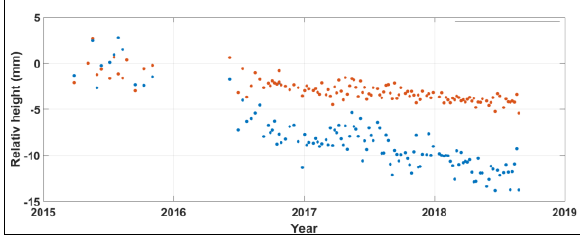
Figure 8: Time series from PSI. PS cluster for High Dune district in red, Nearest PS cluster in blue. The data gap is related to missing Sentinel-1